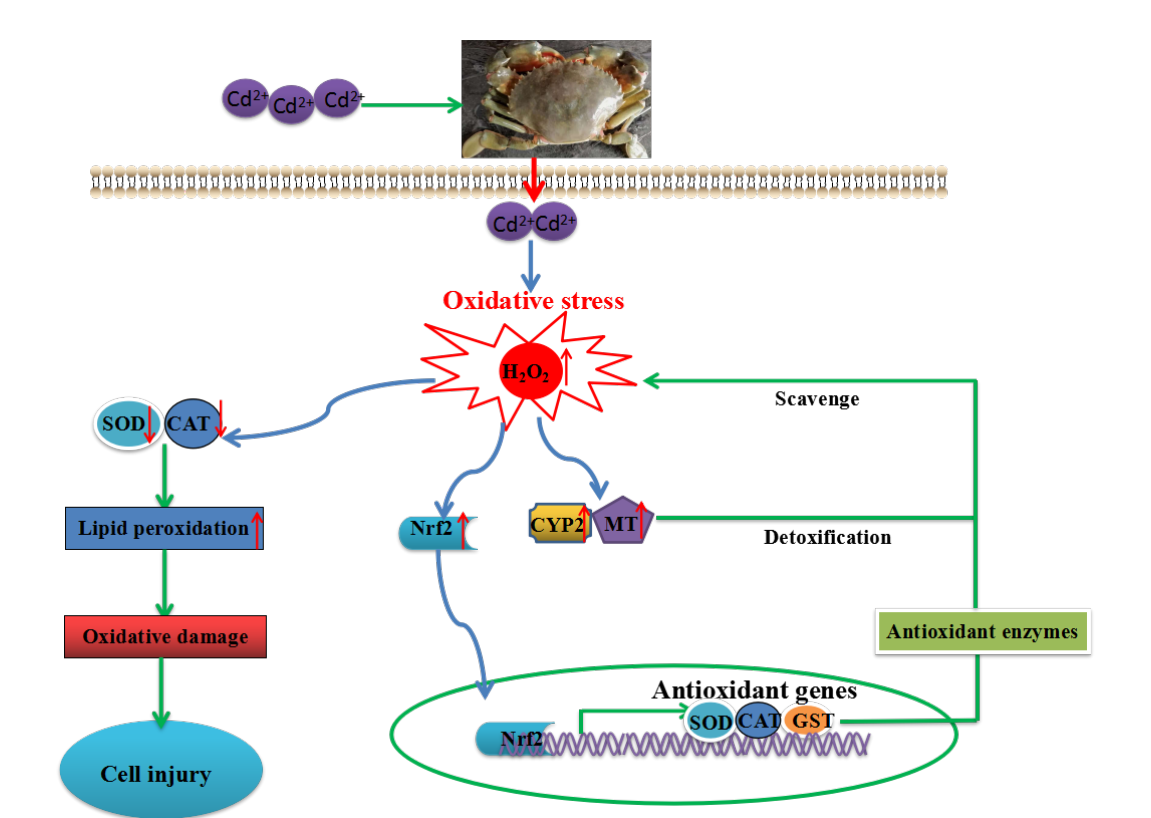
Figure 6. The percentage survival of mud crabs in the dsNrF2 group and dsGFP group (the dsGFP group was used as the control) after cadmium exposure. Asterisks reflected significant differences between the dsNrf2 group and the dsGFP group.